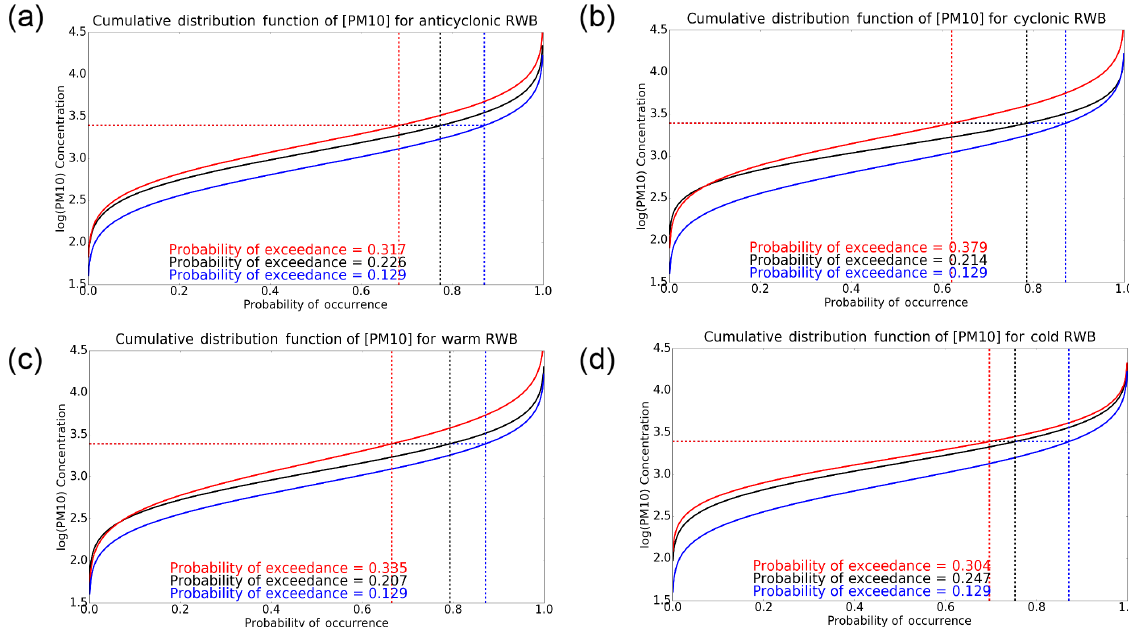
Figure 5. Cumulative distribution functions (CDFs) for UK ln[PM 10 ] and (a) anticyclonic, (b) cyclonic, (c) warm and (d) cold RWB. The red line illustrates the CDF for each RWB subset following a day with RWB of any type within the respective region of influence (continuous event). The black line illustrates the CDF for each RWB subset following a day with no RWB of any type (onset event), and the blue represents [PM 10 ] associated with no RWB. Data were obtained for DJF January 1999–December 2008, and [PM 10 ] is lagged by 1 day following detection of RWB. Values shown for probability of exceedance are calculated as 1 α , where α is the probability of